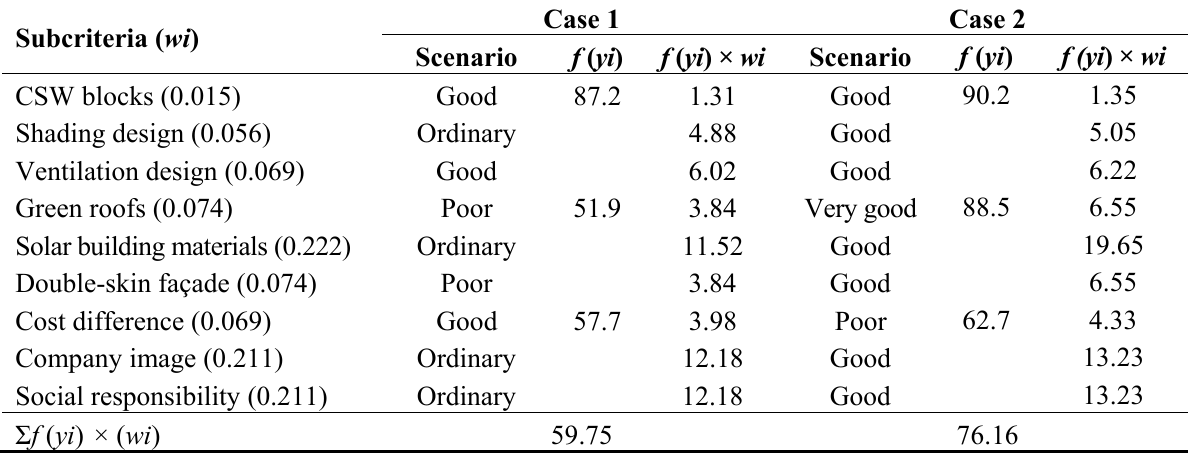
Table 10. Comprehensive evaluation of energy-saving design for Cases 1 and